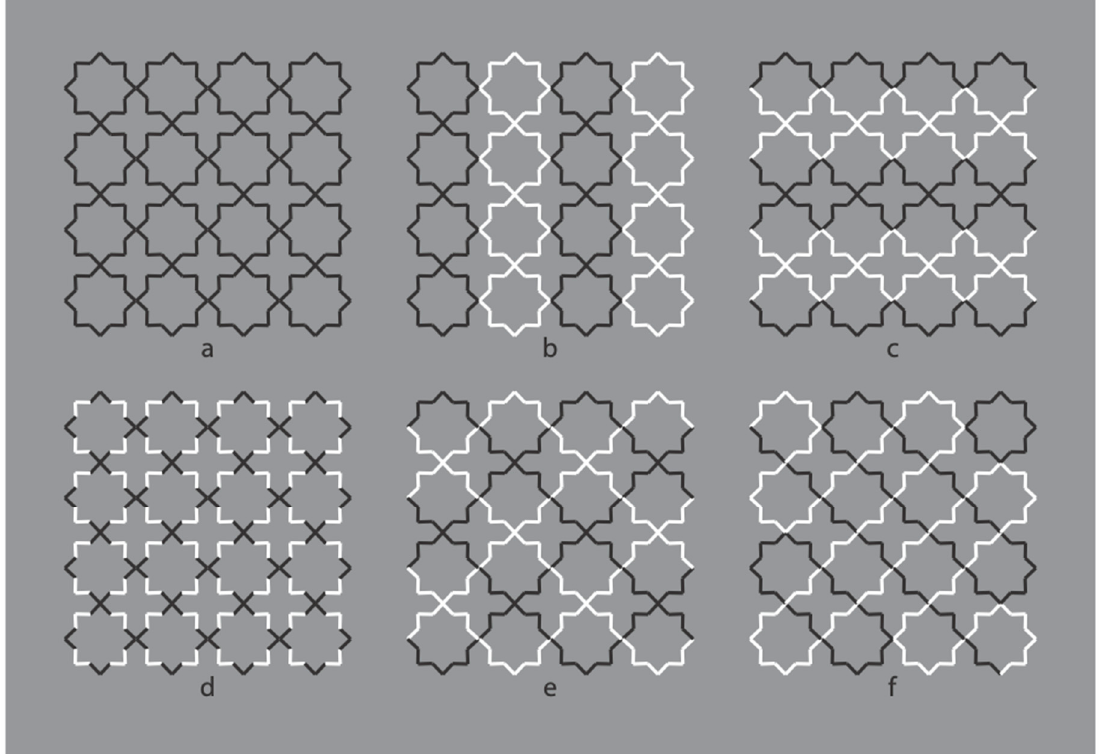
Figure 8. New regular and simpler results elicited by contrast polarity.